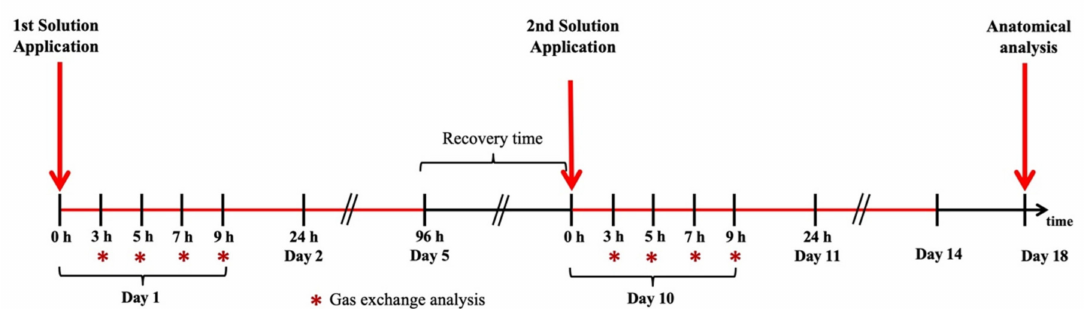
Figure 6. Time line of the experimental design for the methyl jasmonate (MeJa) application, gas exchange and anatomical analysis that were performed. The first and second red arrows show MeJa application at days 1 and 10 at 0 h. The third red arrow shows root collection for anatomical analysis. Red stars indicate gas exchange